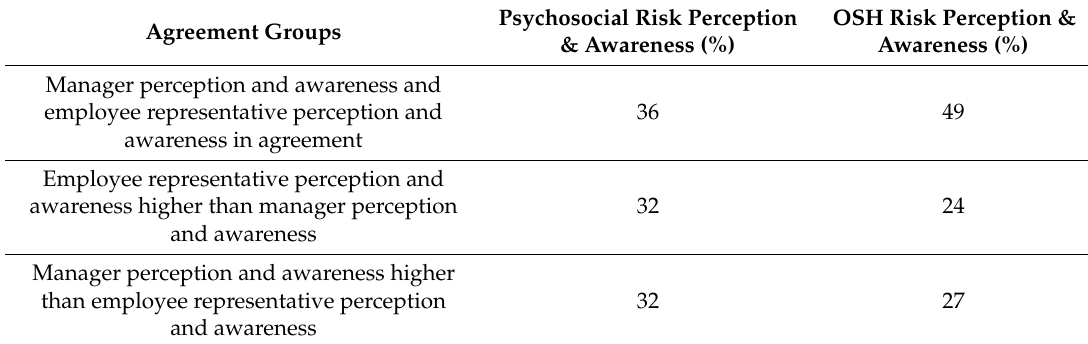
Table 3. Agreement in psychosocial risk perception and awareness and OSH risk perception and awareness between managers and employee